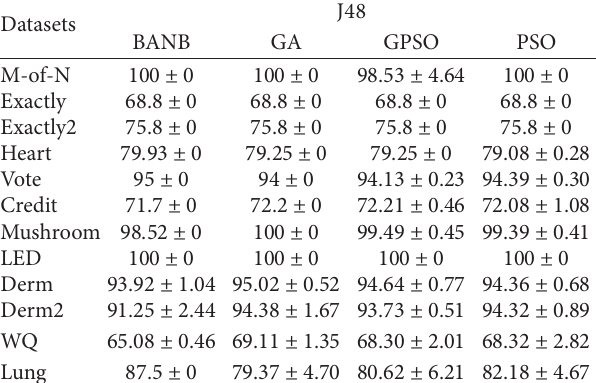
Table 6: Average classification accuracy and standard deviation for